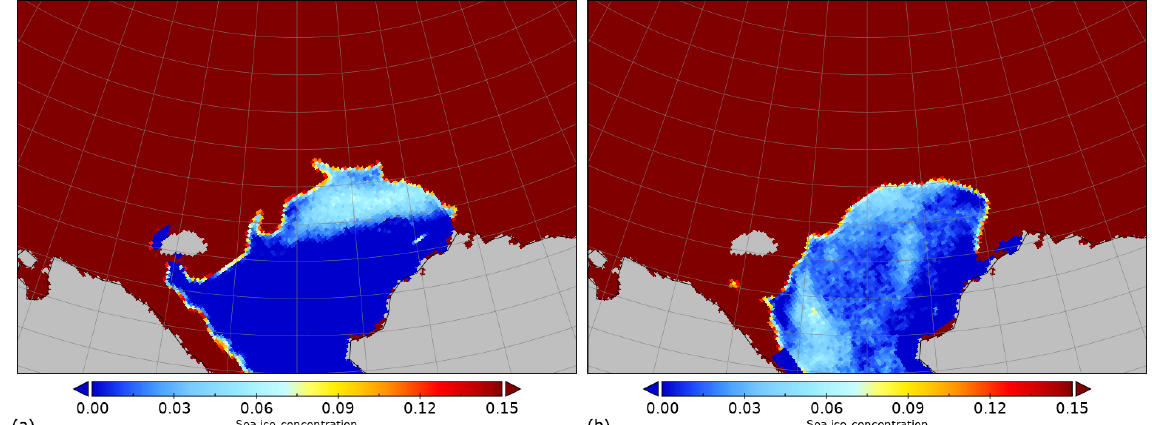
Figure C2. Apparent OSISAF-AMSR2 SIC noise in the open water during the R/V Mirai MIZ transect observation. SIC estimates on 15 November (a) and 20 November 2018 (b)